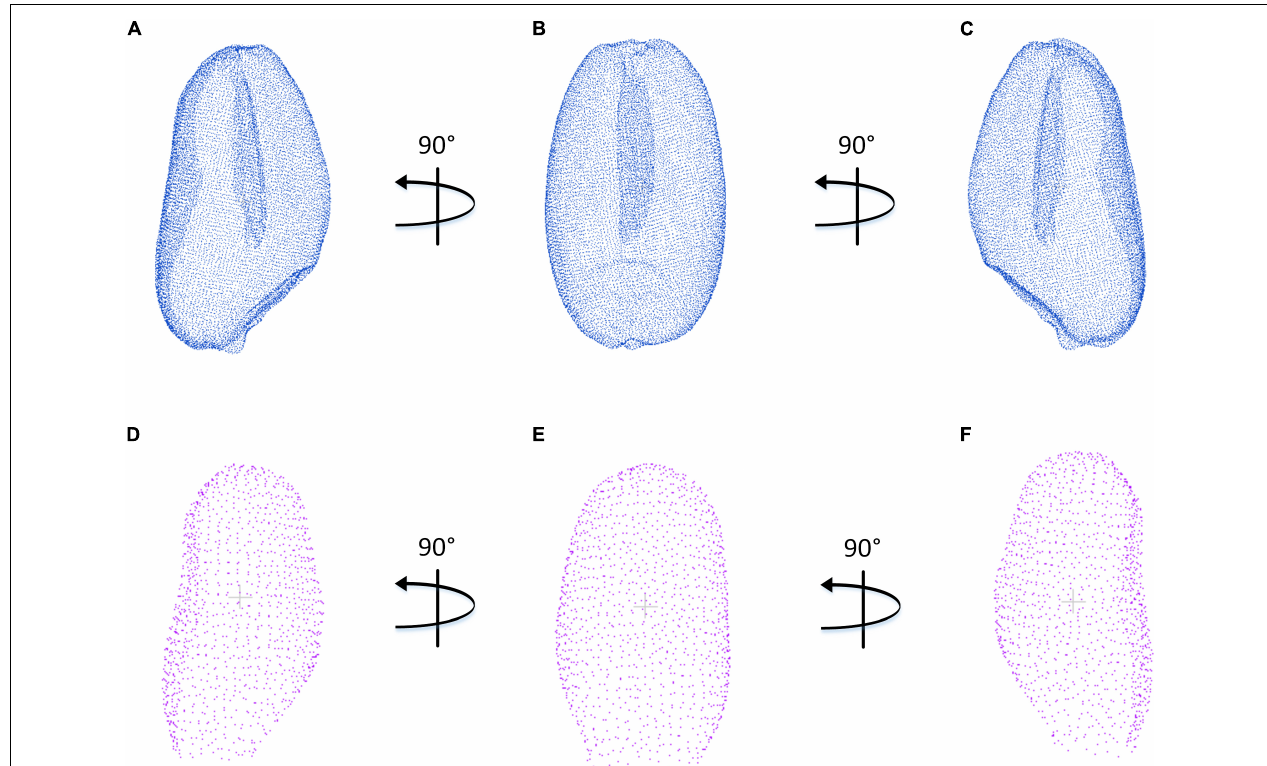
FIGURE 10 | Comparison of wheat grain point clouds obtained by X-ray CT and structured light imaging. (A–C) X-ray CT system. (D–F) Structured light